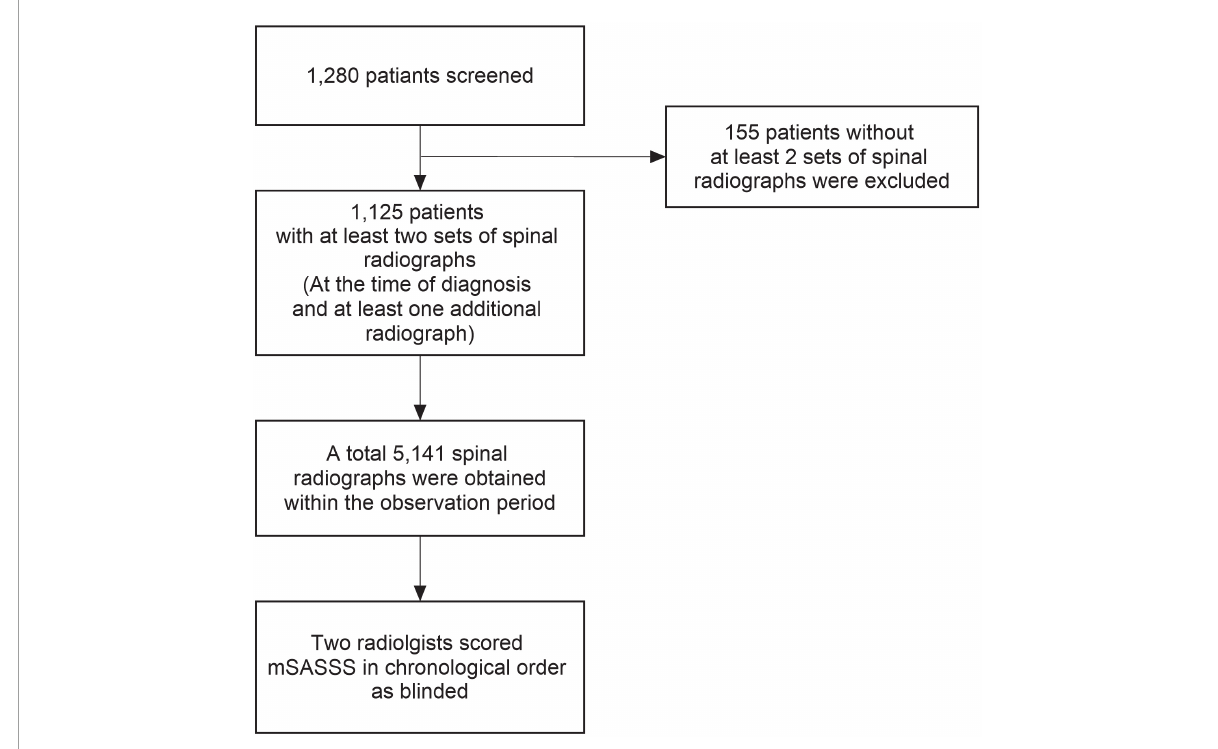
FIGURE1 Flowchart of patient selection and radiographic data collection. mSASSS, modified Stoke Ankylosing Spondylitis Spinal